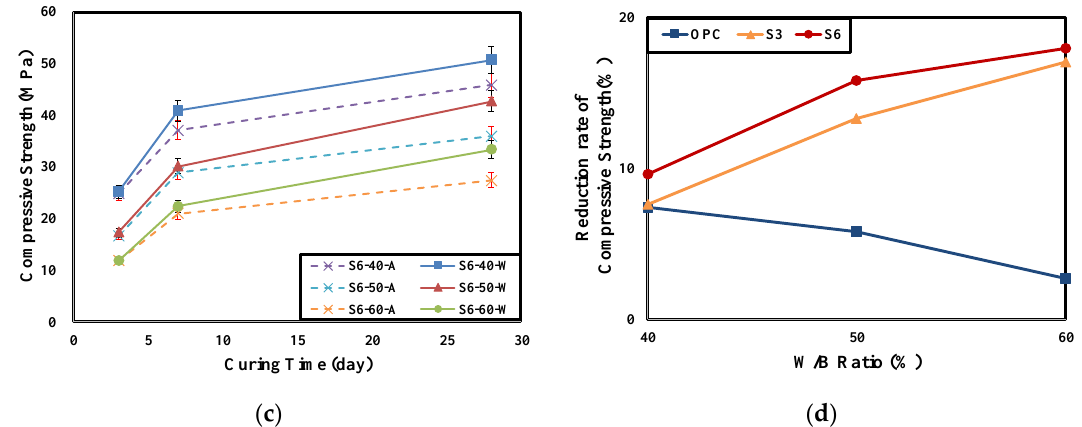
Figure 7. Compressive strength of concrete according to curing day and curing condition. ( a ) Ordinary Portland cement (OPC), ( b ) OPC 70% + GGBFS 30%, ( c ) OPC 40% + GGBFS 60%, ( d ) Reduction rate of Compressive strength according to W/B(28d). Table 5. Result of compressive strength test.